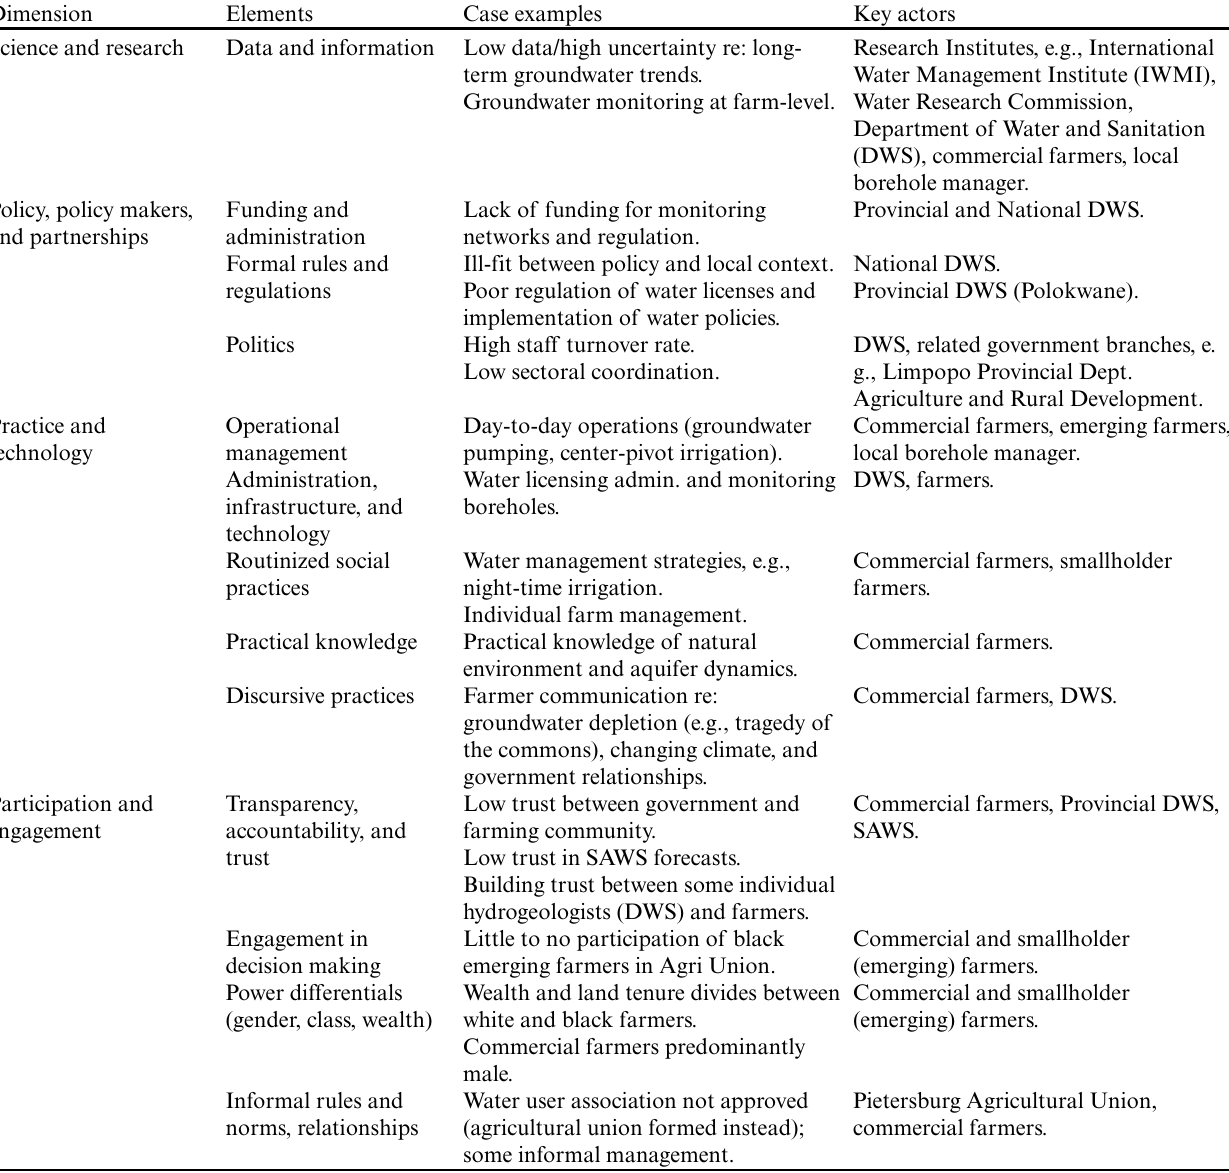
Table 2 . Key elements of the Doringlaagte Basin through the